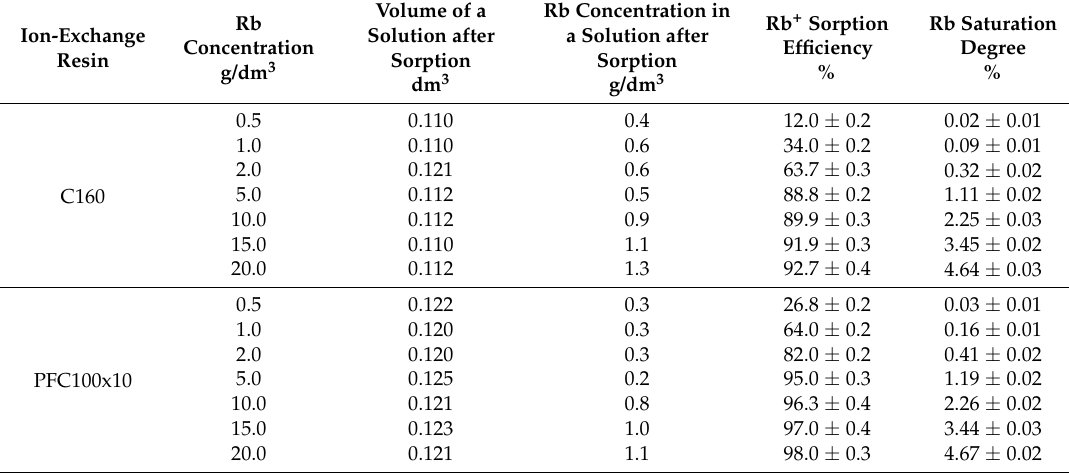
Table 3. Effect of the rubidium concentration on the rubidium ion sorption efficiency.